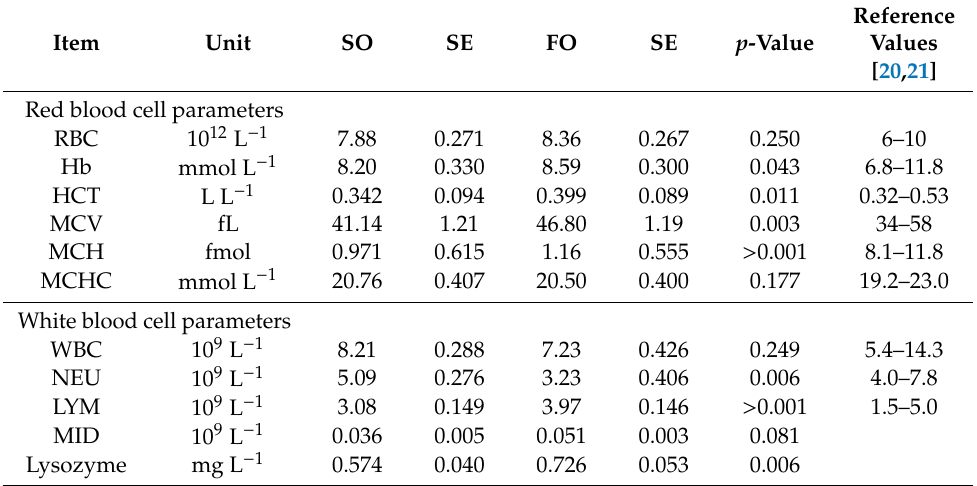
Table 4. E ff ect of dietary oils on haematological parameters (mean ± SE) of